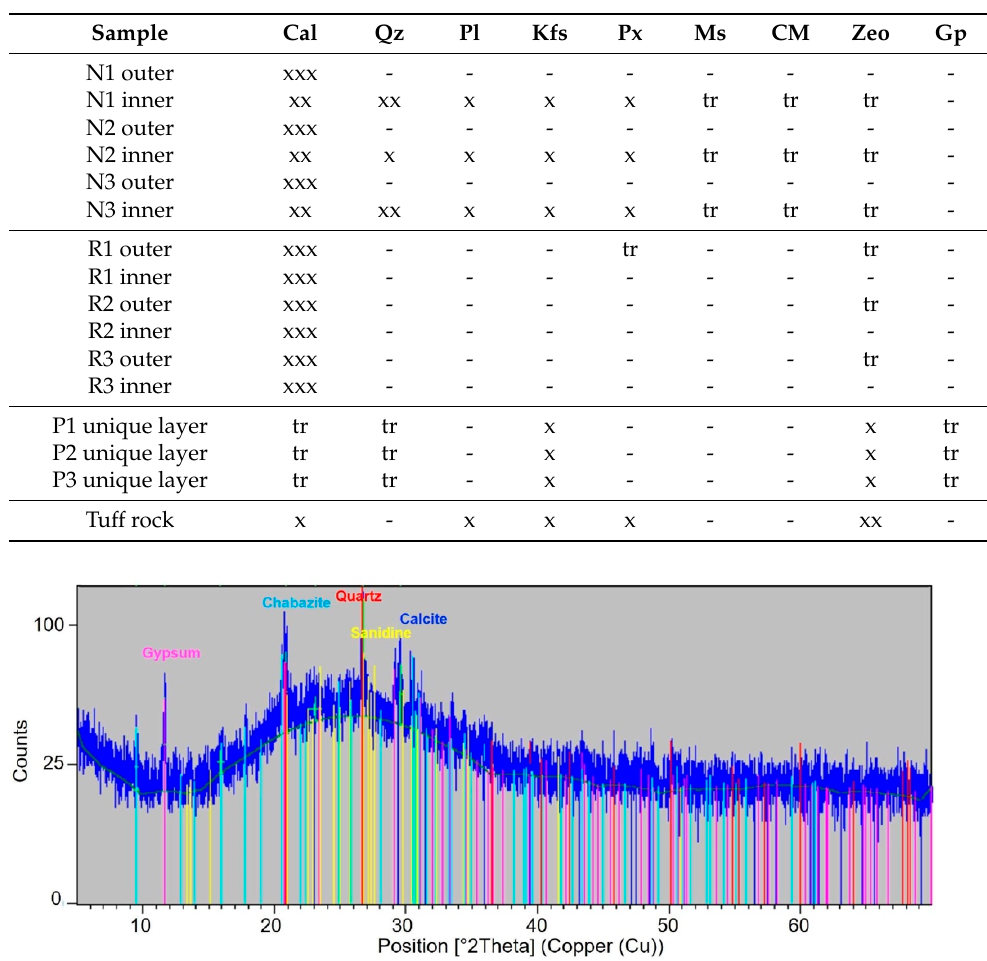
Table 2. XRD results of the analysis of the preparatory layers. Cal, calcite; Qz, quartz; Pl, plagioclase; Kfs, K-feldspar; Px, pyroxene; Ms, mica; CM, clay minerals; Zeo, zeolite; Gp, gypsum. xxx, high amount; xx, medium amount; x, low amount; tr, traces.